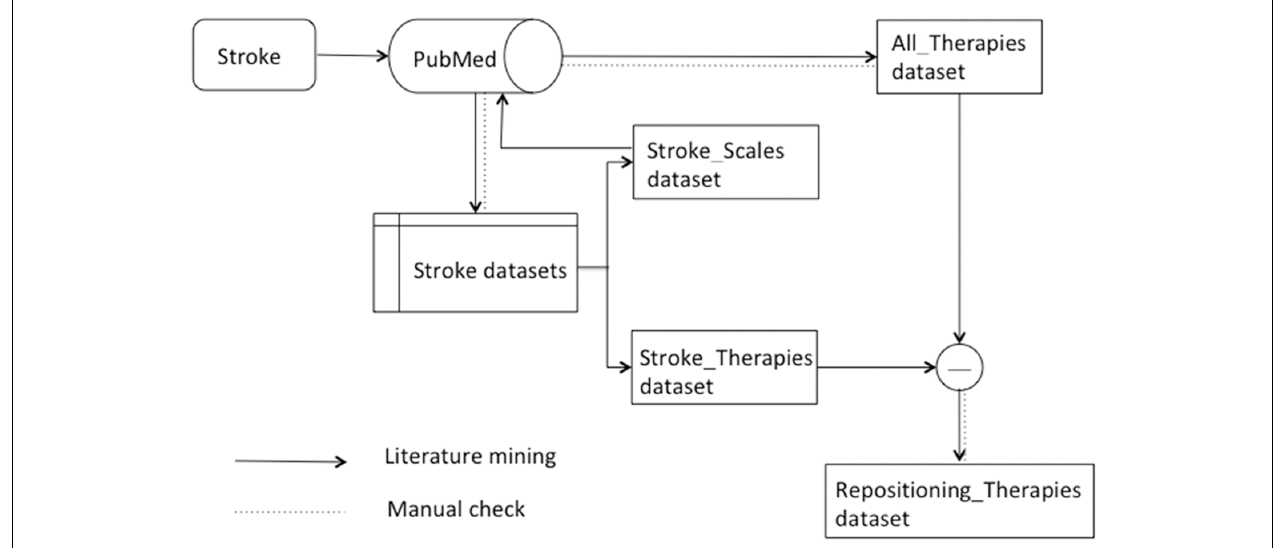
FIGURE 2 | Flow chart from stroke to repositioning rehabilitation therapies. __Indicates text mining process in this study. ... Indicates manual inspection in this